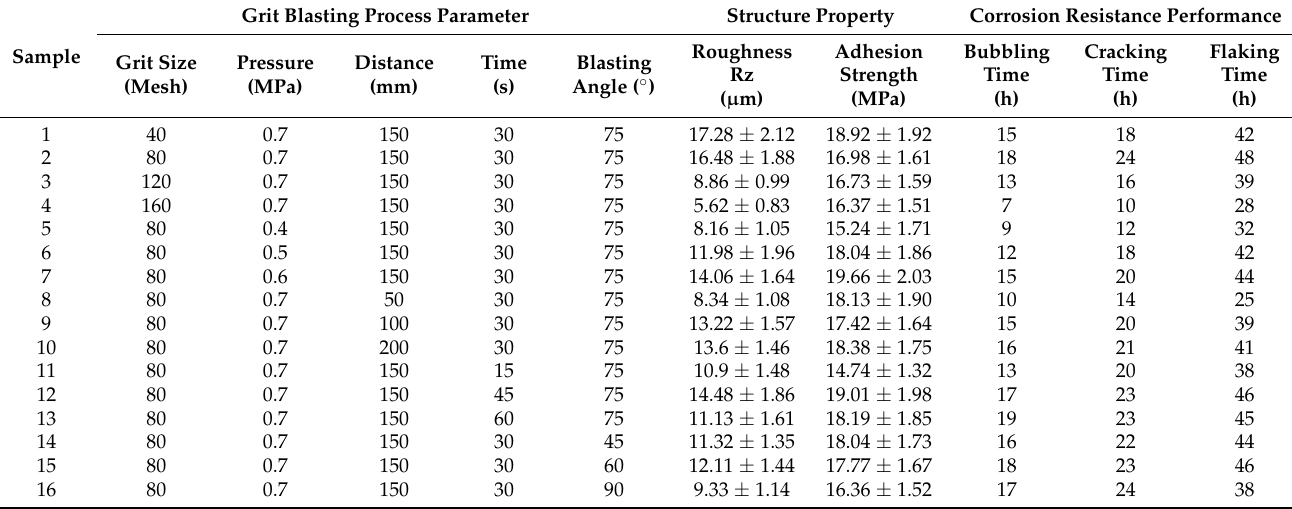
Table 3. Summary of grit blasting process parameter settings and measured